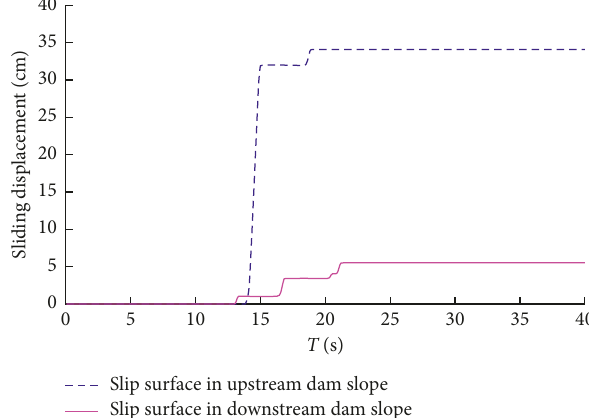
Figure 13: Time history sliding displacements of slip surfaces in upstream and downstream dam